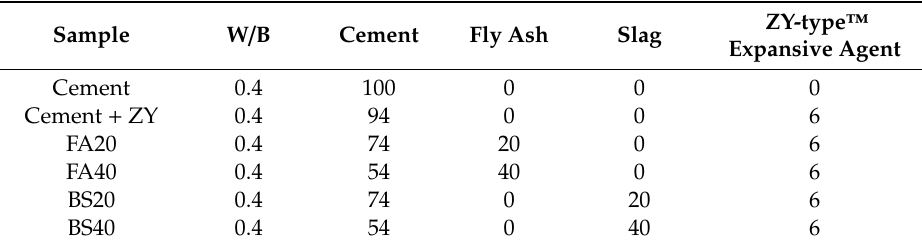
Table 2. Mix proportions of pastes (wt.%).